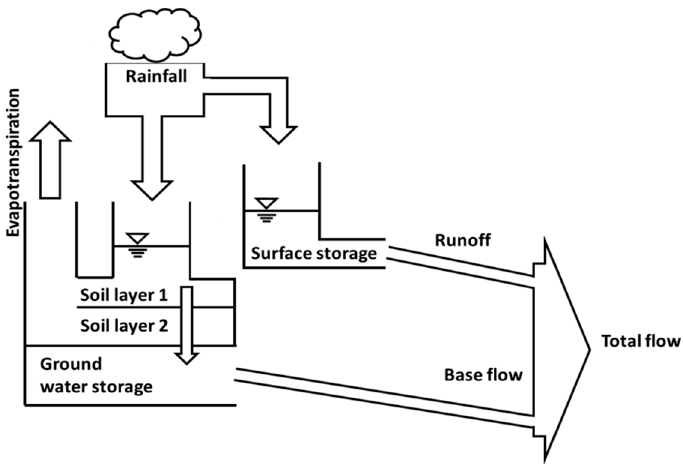
Figure 1. Depiction of soil water balance based on the continuous streamflow model [7,8].